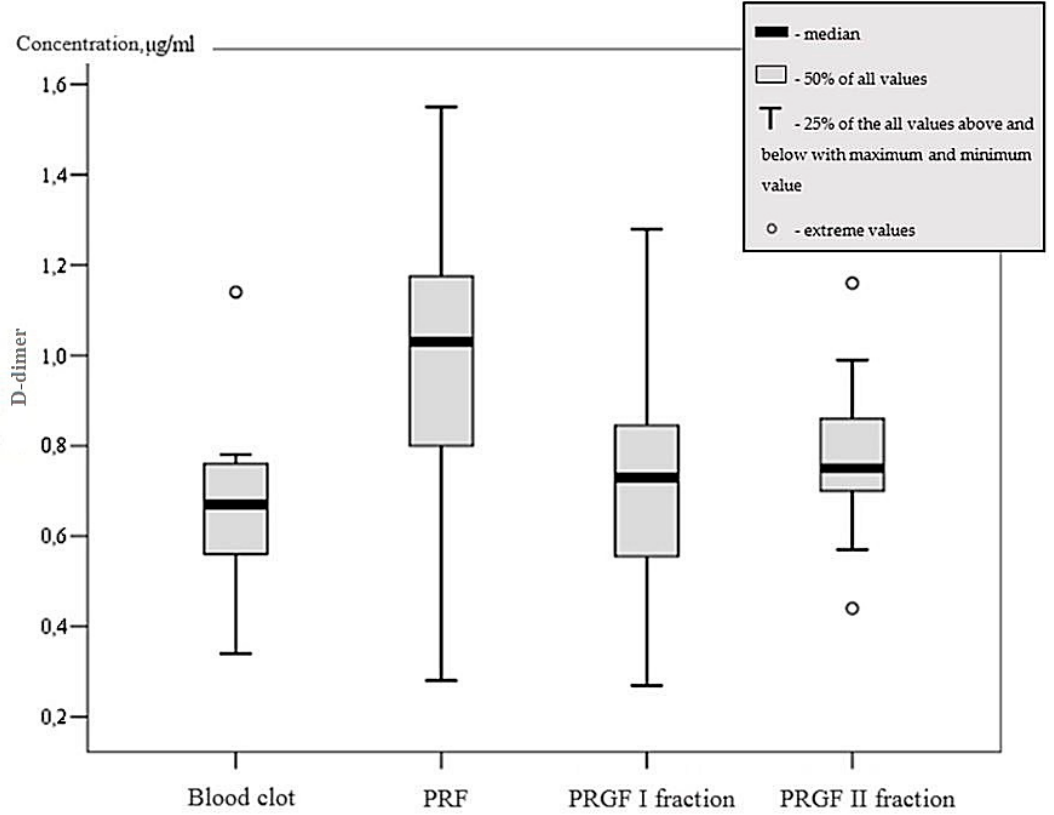
Figure 1. d -dimer concentration based on medium in C. albicans Figure 1. D -dimer concentration based on medium in C. albicans group.